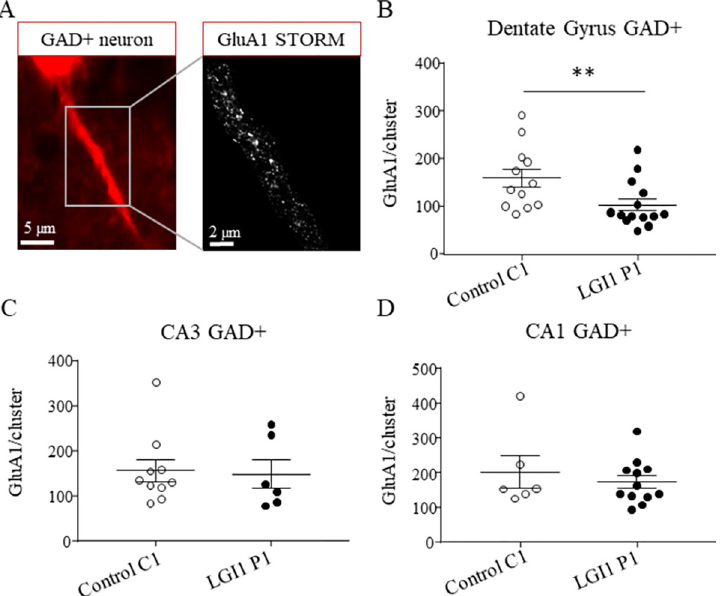
Fig 2. LGI1 Abs decrease the expression of AMPA-R inside clusters at the surface of interneurons in the hippocampus. Epifluorescence images (100x objective) of an inhibitory GAD+ neuron expressing td-tomato (left image). Magnification of the corresponding super-resolution STORM image showing the expression of GluA1 subunits along the neuronal extension (right image) (A). The total density of surface GluA1 subunits decreased after LGI1 P1 IgG infusion compared to control C1 IgG infusion at the surface of interneurons in the DG (Mann-Whitney �� p = 0.0091, n Ctrl = 12 neurons, n LGI1 = 14 neurons) (B) but not in CA3 region (Mann-Whitney test p = 0.63, n Ctrl = 11 neurons, n LGI1 = 6 neurons) (C) nor CA1 region of the hippocampus (Mann-Whitney t-test p = 0.68, n Ctrl = 6 neurons, n LGI1 = 12 neurons) (D). Data are represented as means ± SEM (analysis realized from n Ctrl = 4 mice, n LGI1 = 3 mice).